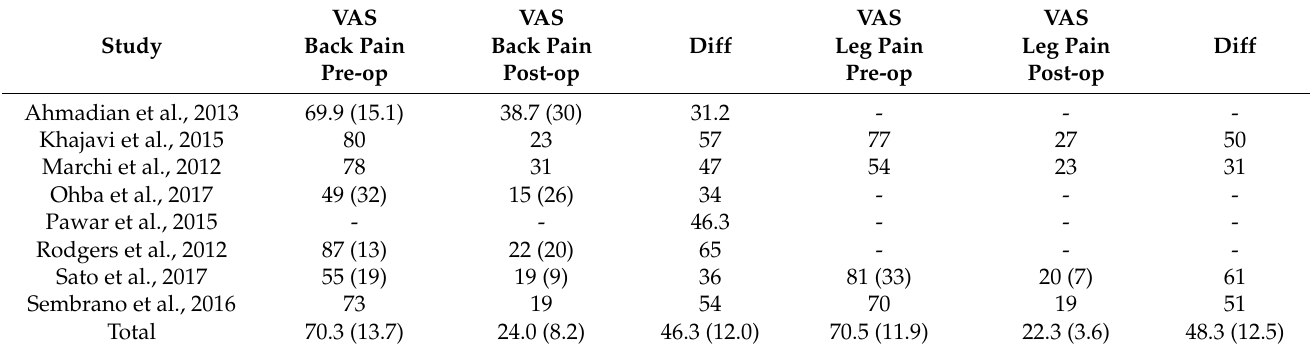
Table 3. Patient-reported outcomes measures (pain intensity) by the included